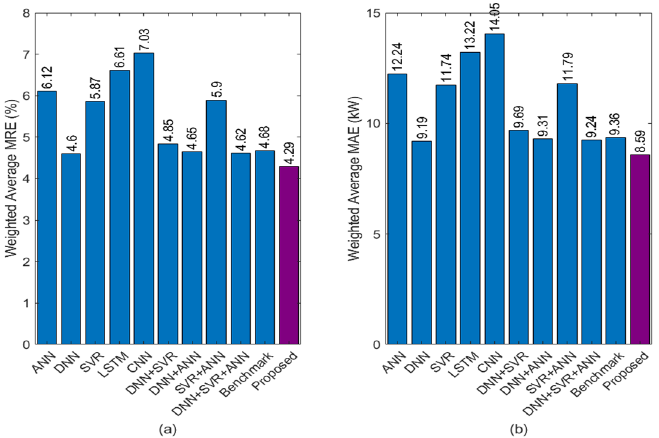
Figure 16. The comparison of weighted average three-day ahead hourly forecasting performance Figure 15. Three-day ahead PV power forecasting results for rainy days between single model and ( a ) MRE and ( b ) MAE among the single, combination, benchmark, and proposed methods. ensemble